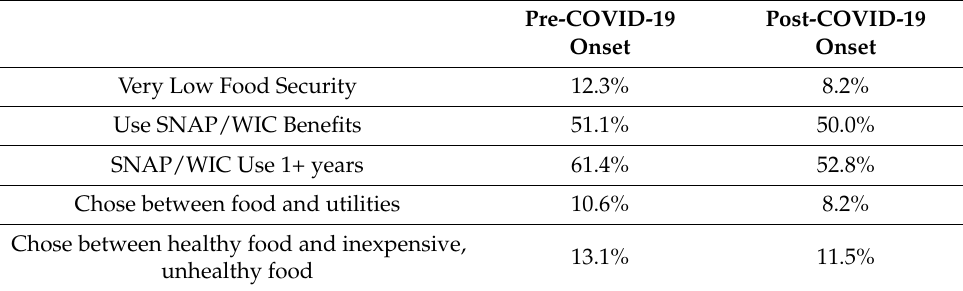
Table 2. Rates of Food Security and Federal Nutrition Program Participation.